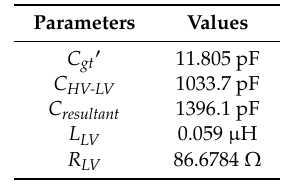
Table 6. RLC parameters of the LV